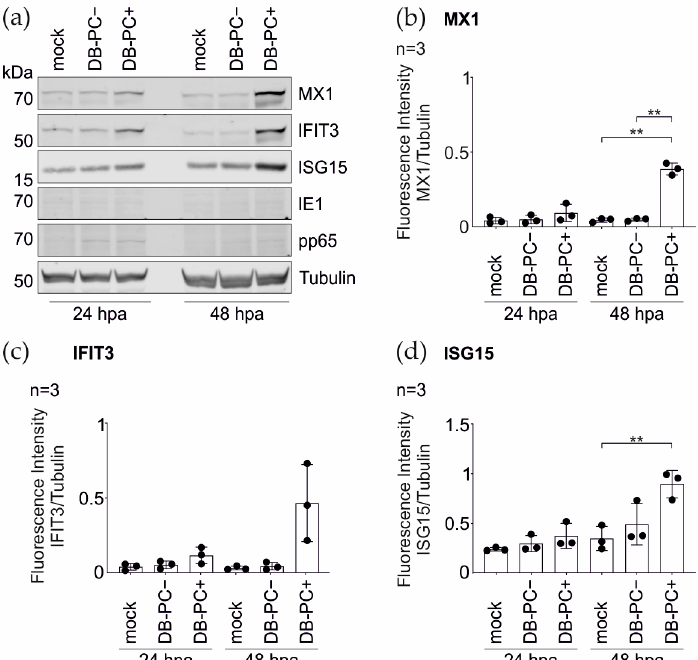
Figure 5. Western blot analysis of the IRG expression in endothelial cells (EC) after DB-exposure. ECs were incubated with 20 μ g of UV-inactivated DBs of TR- Δ GFP (DB-PC+) or DBs of TR-BAC (DB-PC − ) for 24 h and 48 h. Cell extracts were analyzed for the MX1, IFIT3, and ISG15 expression. ( a ) Western blots were probed with antibodies against MX1, IFIT3, and ISG15. The viral IE1-protein was visualized to verify an infectious virus. Internalization of DBs into endothelial cells was visualized by the detection of the phosphoprotein 65 (pp65). Tubulin was probed as the sample loading control. For quantification in ( b – d ), the ratio of the fluorescence intensity of each IRG protein band to the corresponding tubulin band was measured using the LICOR Image Studio Lite (Ver 5.2.5) software. The values of three independent experiments were plotted. Error bars represent the SD. Comparisons between the groups were calculated using the unpaired t -test with Welch ´ s correction. ** p < 0.01.